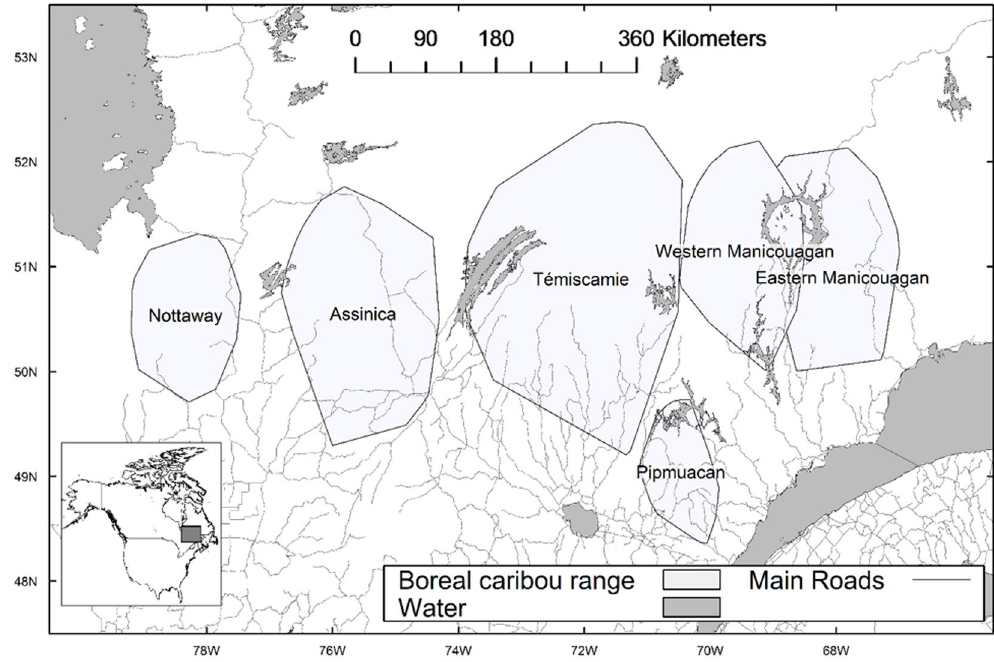
Figure 5. Location of six populations of boreal caribou that were monitored in eastern Canadian boreal forest. The figure was created in the R statistical environment 73